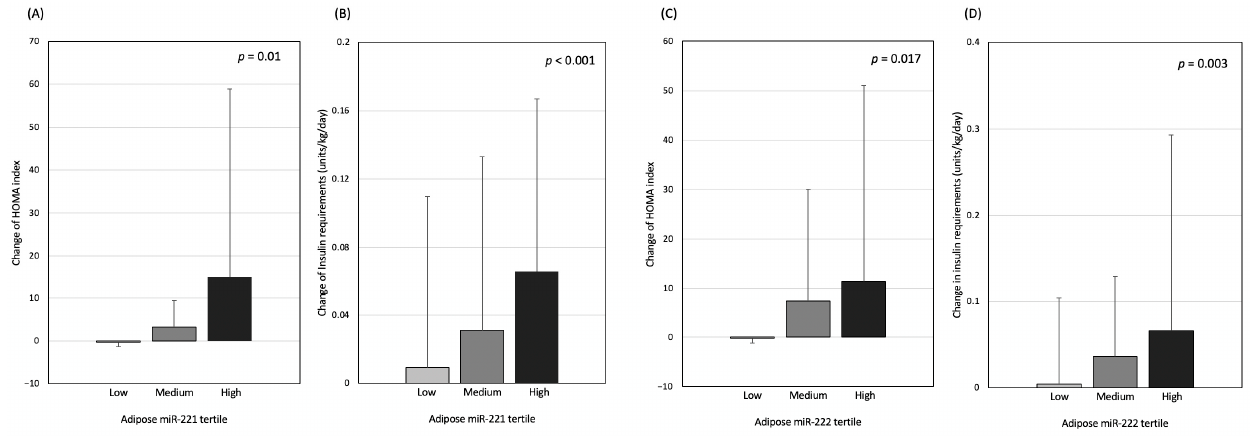
Figure 3. HOMA and daily insulin requirement change according to adipose ( A , B ) miR-221 and ( C , D ) -222 tertiles.